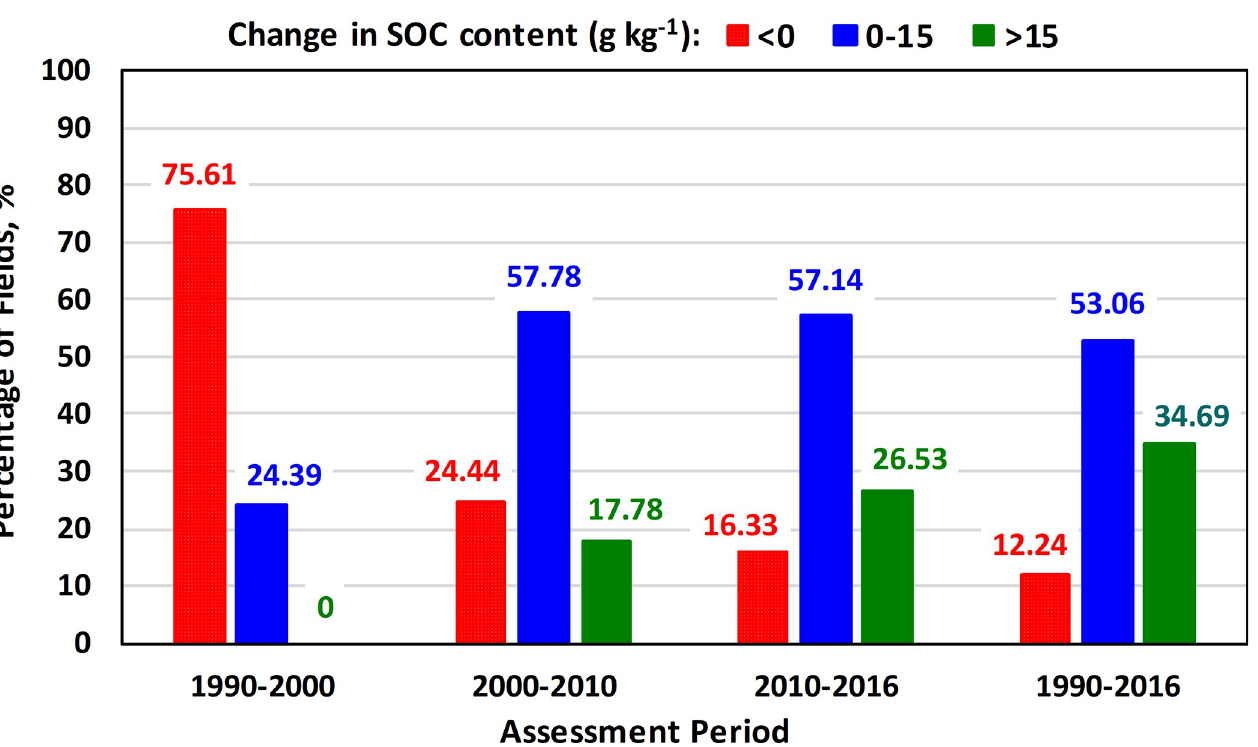
Fig 5. Temporal changes of SOC content across the the experimental